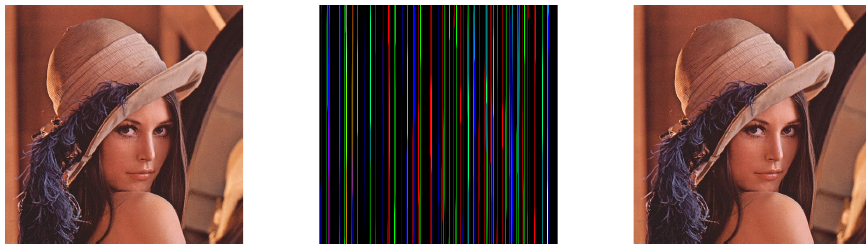
Figure 3. Original image on the left, encrypted image in the chaotic channel in the center, and the recovered image on the